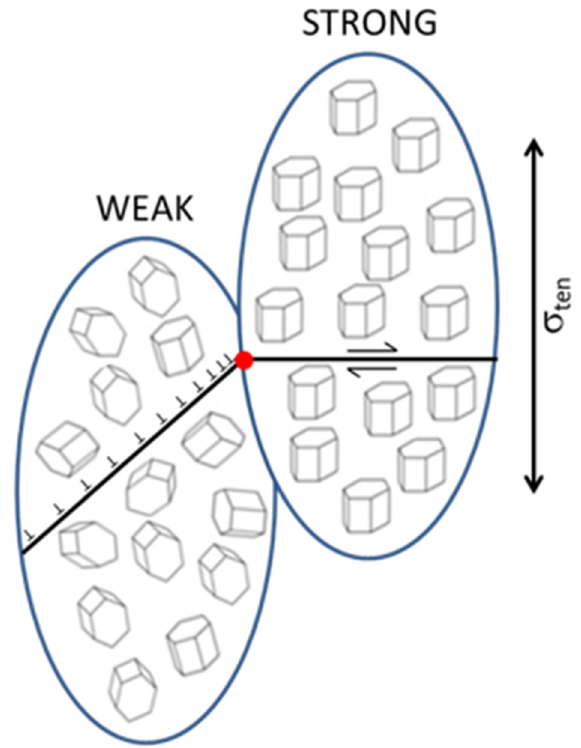
Figure 18. Proposed model to describe redistribution between “strong” and “weak” macrozones (MTRs) in finer scaled microstructures [12].